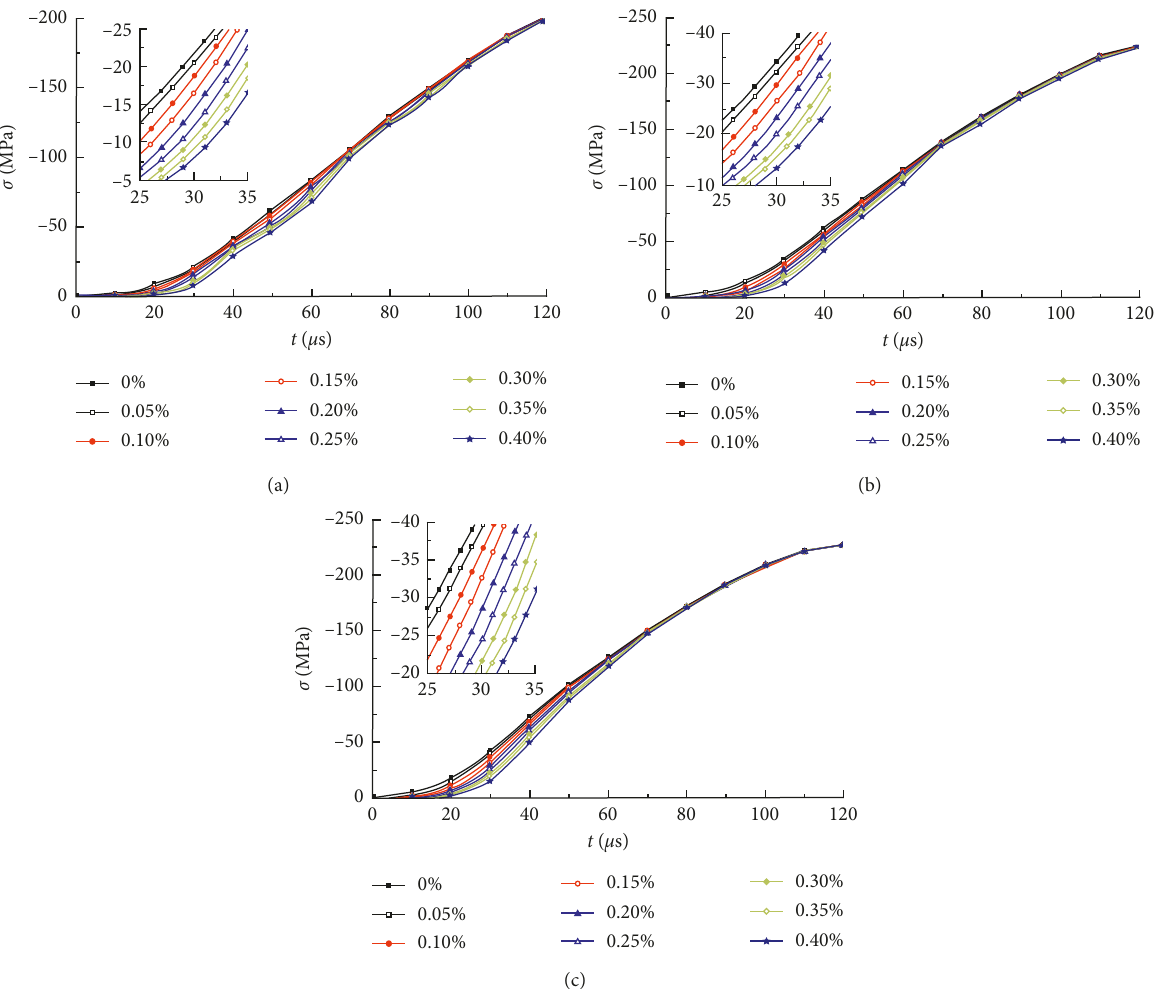
Figure 5: Transmitted stresses of rock specimens for various end-surface nonparallelisms: (a) E